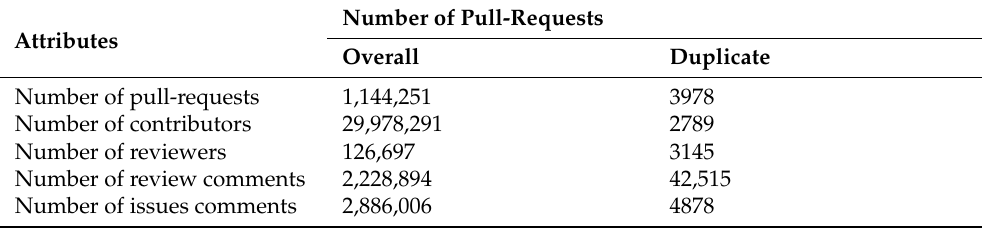
Table 3. Dataset description of DupPR-complementary